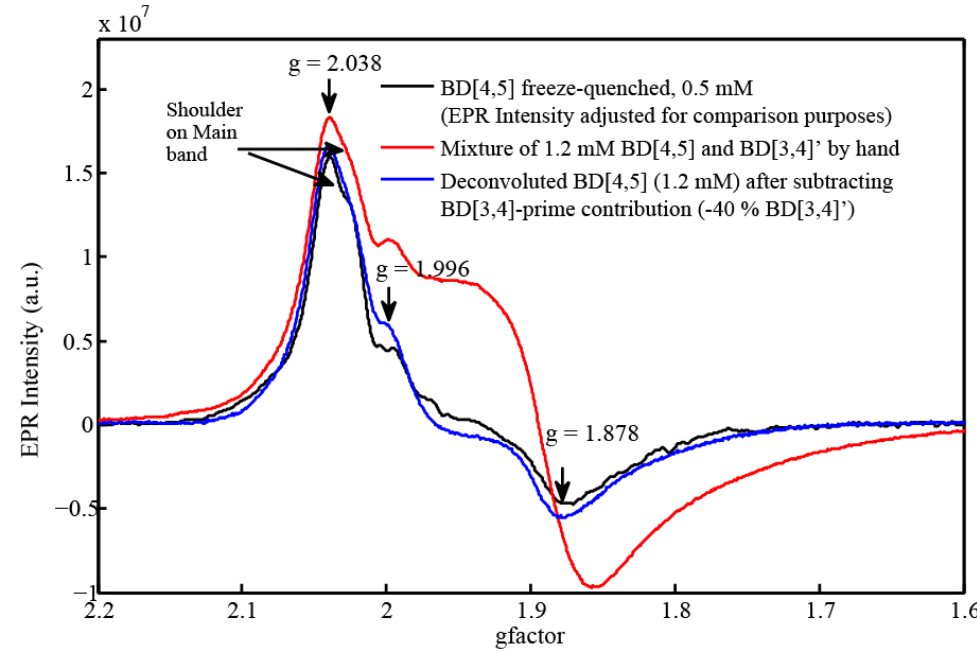
Figure A1. EPR spectra of BD[4,5] freeze-quenched at higher concentration (0.5 mM, pH 1 in HNO ) in comparison with mixture of 60% BD[4,5] and 40% BD[3,4] ′ prepared 3 ). BD[4,5] after subtracting 40% of BD[3,4] ′ by manual mixing (1.2 mM, pH 1 in HNO 3 contribution is also shown (1.2 mM, pH 1 in HNO ). The shoulder on the main band is 3 emphasized by arrows and the g-tensors are shown. G-tensor components at 2.038 and 1.996 shown by arrows are in agreement with those reported in Figure 5B in [9]. Please note that the EPR intensity of BD[4,5] prepared by freeze quench(0.5 mM) was adjusted for comparison